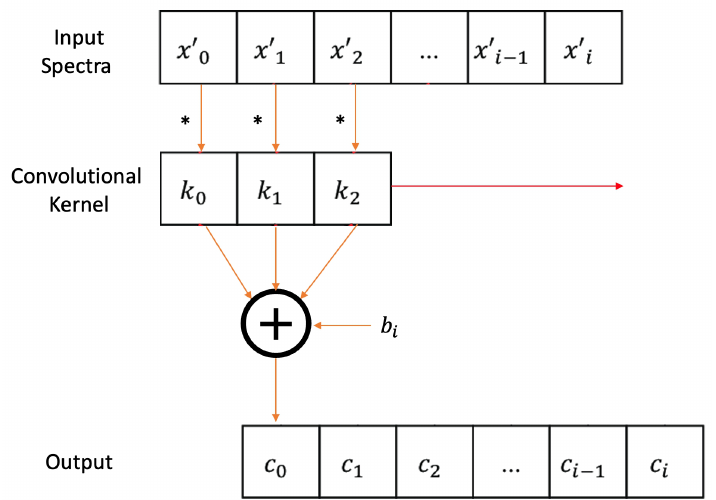
Figure 4. Schematic diagram of 1D convolution